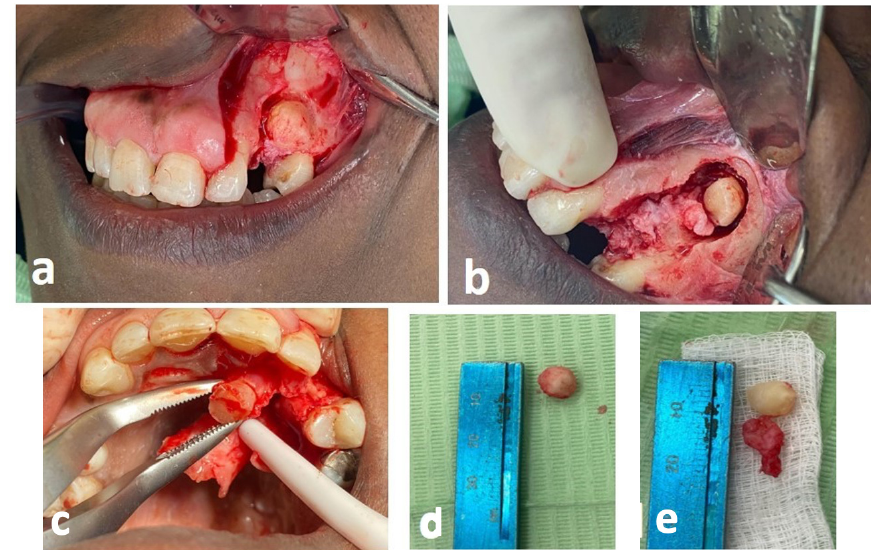
Figure 3. Intra-operative clinical picture showing surgical procedures to extract impacted maxillary left canine, supernumerary and odontoma a ) Labial approach to expose the odontoma. b ) Exposing the supernumerary tooth c ) Palatal approach to extract the impacted maxillary left canine d & e ) Measuring size of odontoma, supernumerary tooth and follicular tissue.